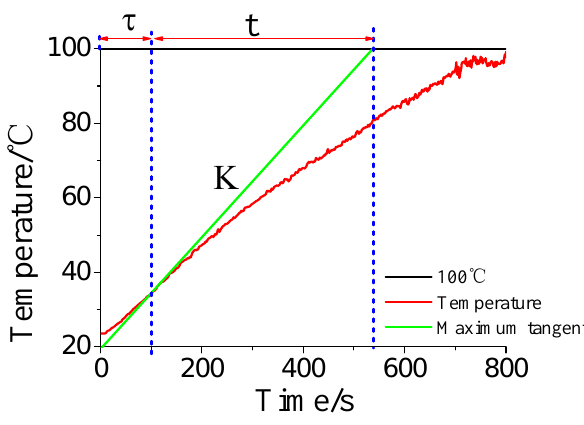
Figure 4. The curve of the system identification.